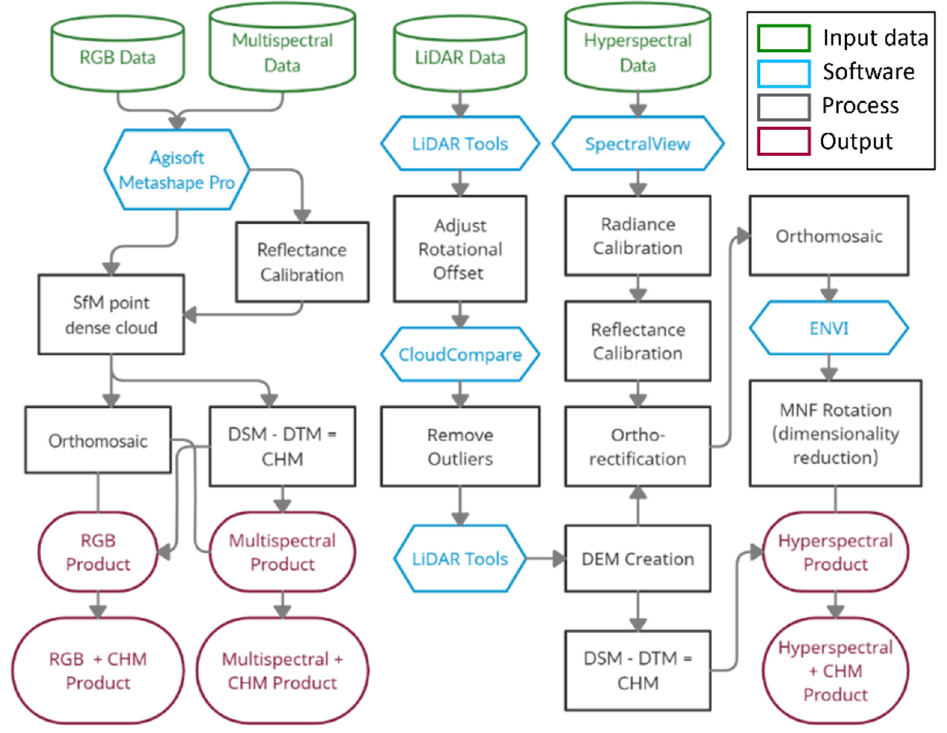
Figure 4. Uncrewed aerial system (UAS) data-processing workflow.